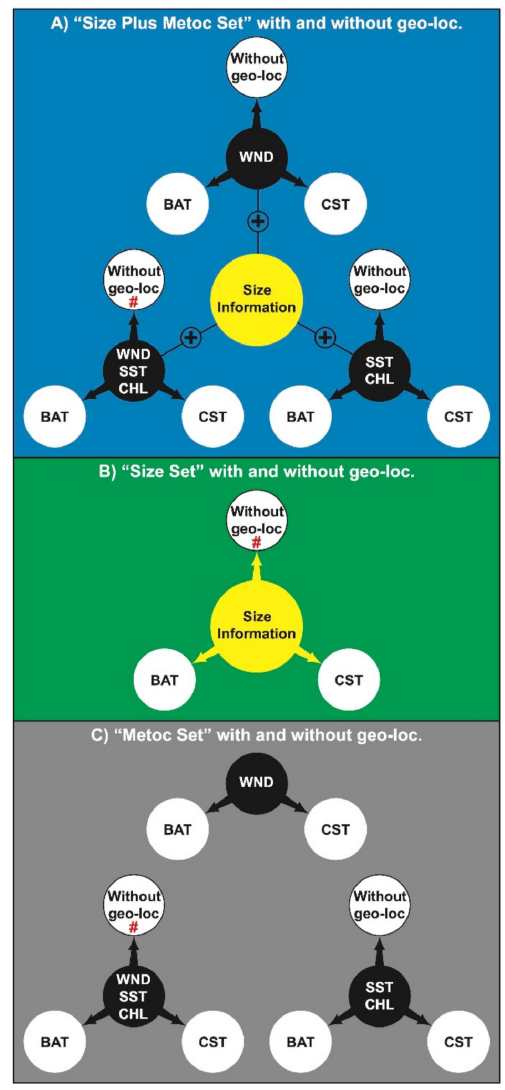
Figure 3. Data combinations explored to evaluate the linear discriminant analysis (LDA) algo- rithms during the data-information experiment fulfilling our first objective, i.e., determine the best combination of variables for linearly discriminating oil spills from look-alike slicks. Color- coded circles represent attribute types. Yellow: size information—area, compact index (CMP: (4. π .area)/(perimeter 2 )), aspect ratio (length-to-width ratio: LtoW), perimeter-to-area ratio (PtoA), fractal index (FRA: 2.ln(perimeter/4)/ln(area)), and number of parts of each feature (NUM). Black: Meteorological-Oceanographic (metoc) variables—wind speed (WND), sea-surface temperature (SST), and chlorophyll-a concentration (CHL). White: geo-location (geo-loc) parameters—bathymetry (BAT) and distance to coastline (CST). Colored panels correspond to attribute-type subdivisions: ( A ) blue (“Size Plus Metoc Set”—9 data combinations); ( B ) green (“Size Set”—3 data combinations); and ( C ) gray (“Metoc Set”—8 data combinations). Each of these 20 combinations had all variables subjected to the same data transformation (i.e., non-transformed, cube root, or log 10 ), thus forming 60 combinations. Combinations previously explored in Carvalho et al. [42] are indicated (#). See also Section